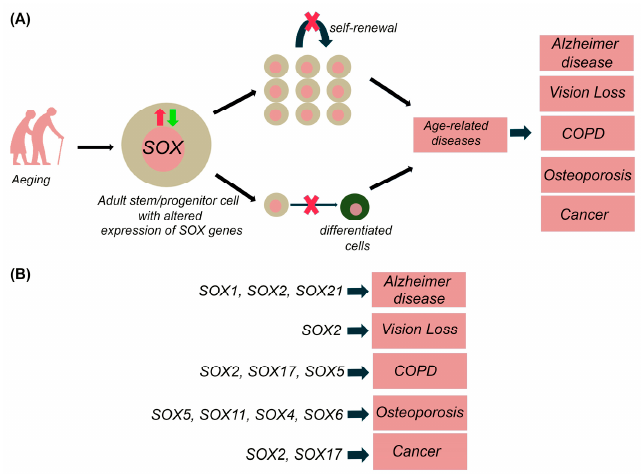
Figure 3. Role of SOX genes in stem cell exhaustion and age-related diseases. ( A ) Altered expression of SOX genes in adult stem/progenitor cells lead to decrease of self-renewal capacity and inhibition of differentiation of these cells, leading to age-related diseases—Alzheimer diseases, Vision loss, Chronic obstructive pulmonary disease (COPD), osteoporosis, and age-related cancers. ( B ) Alteration in SOX genes expression is correlated with various age-related diseases, including neurodegenerative diseases, vision loss, (COPD), osteoporosis, and cancers. The scheme is based on the previously reported publications [96,98,102–105].